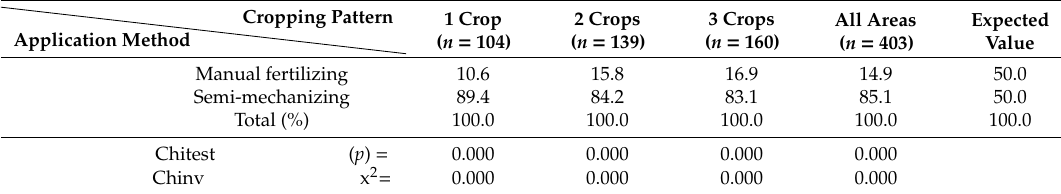
Table 12. Rate of respondents who wanted to use semi-mechanized fertilizer applicator (%). Application